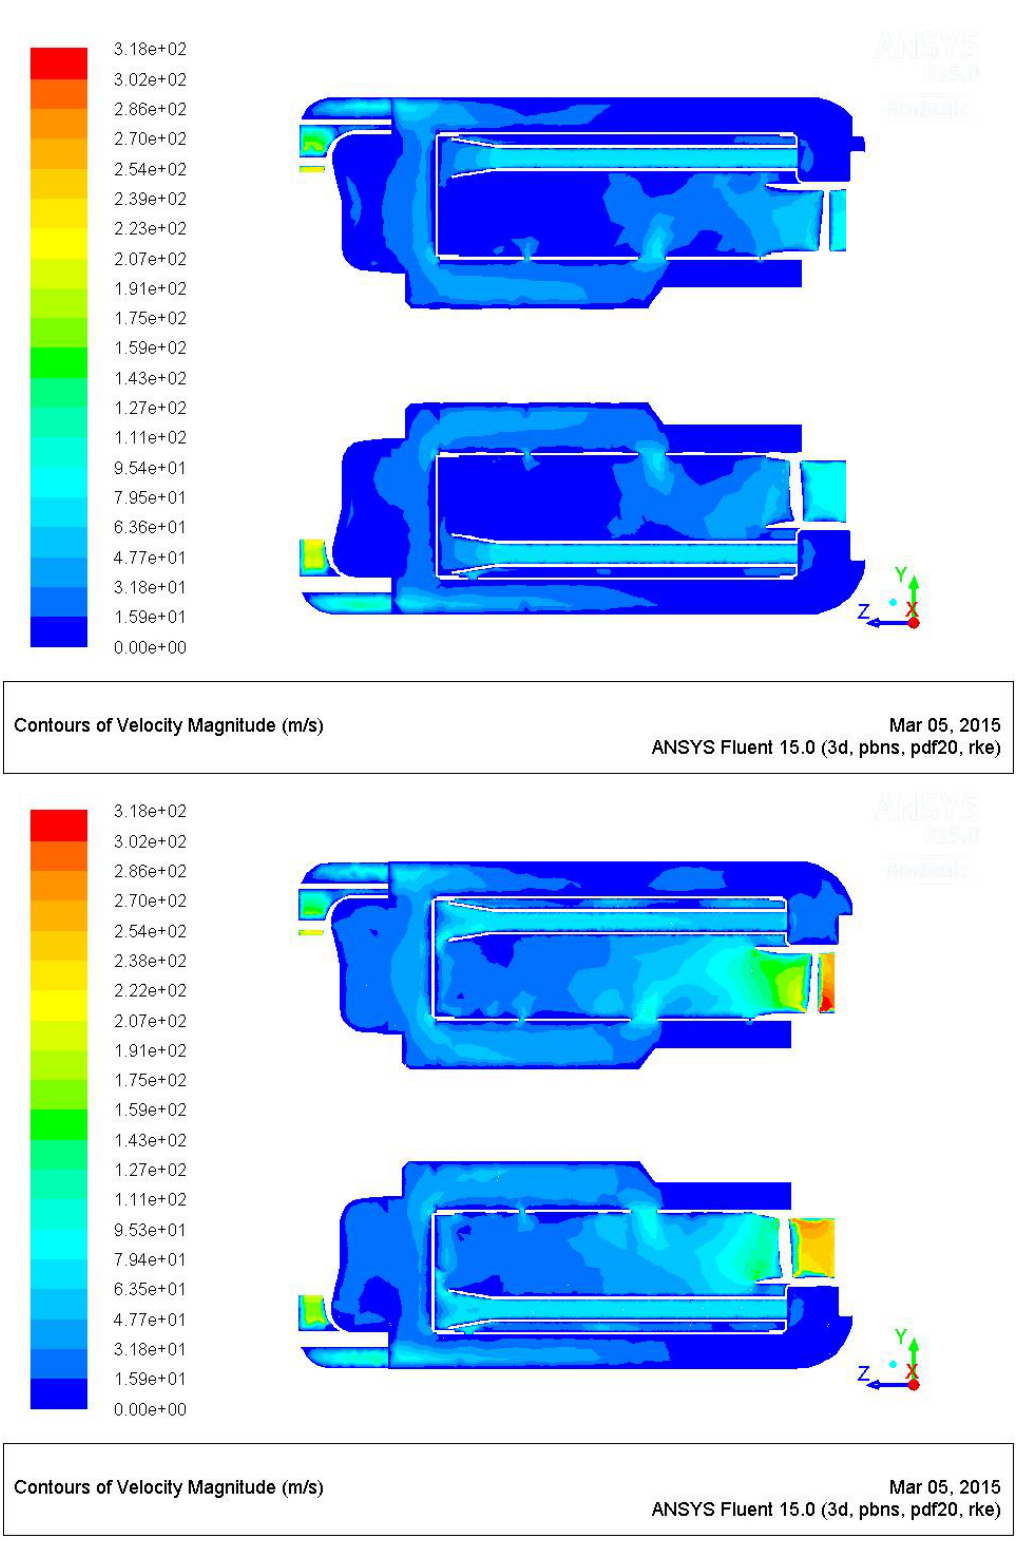
Figure 8: Contours of Velocity Magnitude: - top–cold flow, - bottom–reaction